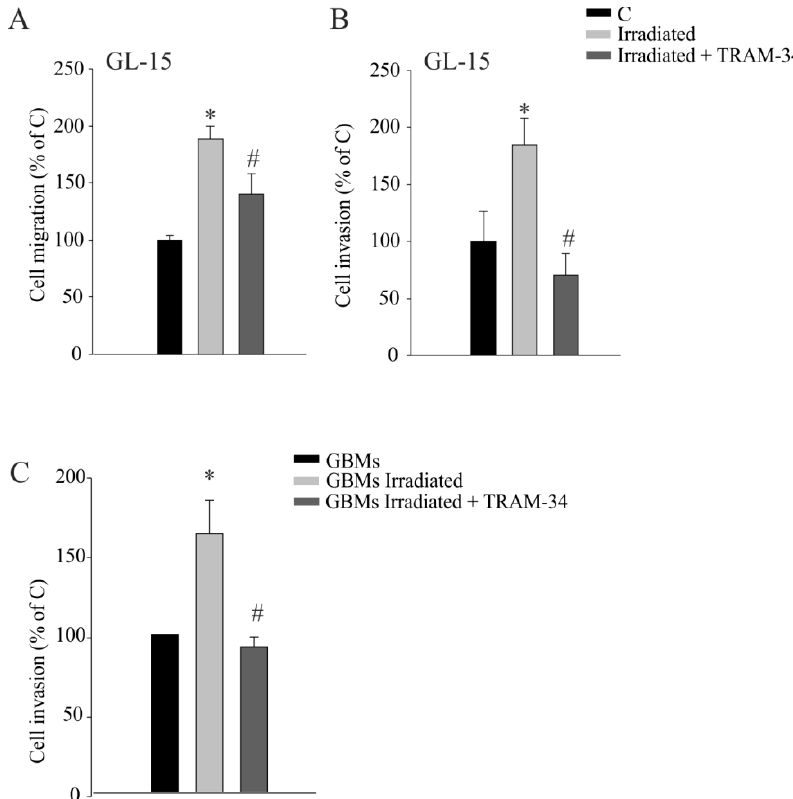
Figure 2. ( A , B ) Migration and invasion assays of irradiated GL-15 cells (after 24 h), in the presence or absence of 5 µM of TRAM-34. * p < 0.05 vs. control (C) GL-15. # p < 0.05 vs. irradiated GL-15 n = 3 (in duplicate); ( C ) Cell invasion assay of irradiated human primary GBMs (GBM18, GBM19, and GBM45) (after 24 h) in the presence or absence of TRAM-34 (5 µM for 24 h), * p < 0.05 vs. control GBMs (C). # p < 0.05 vs. irradiated GBMs. n = 3 (in duplicate).